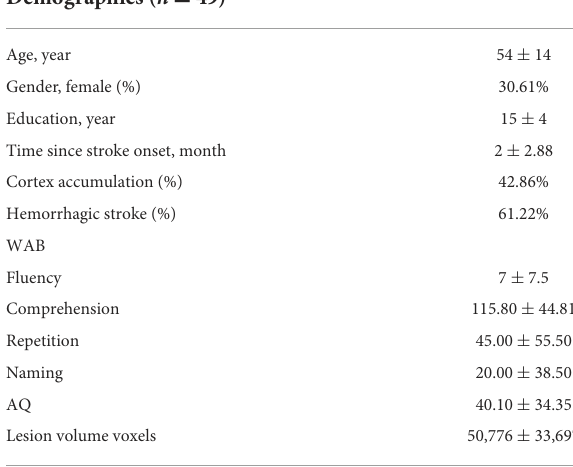
TABLE 1 Demographic and clinical characteristics of the